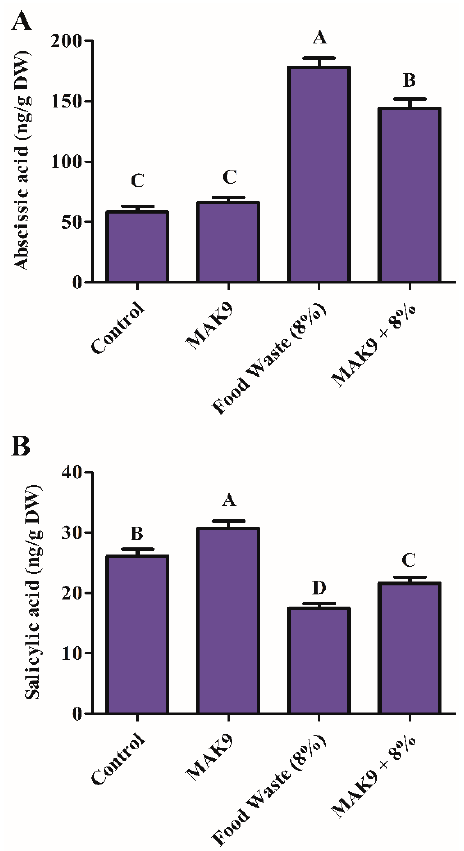
Figure 4. Endogenous abscisic acid ( A ) and salicylic acid ( B ) content in Chinese cabbage after food waste (8%) treatment and/or inoculation with isolate MAK9. Different letters indicate differences between the mean values of three replicates ± standard deviation.